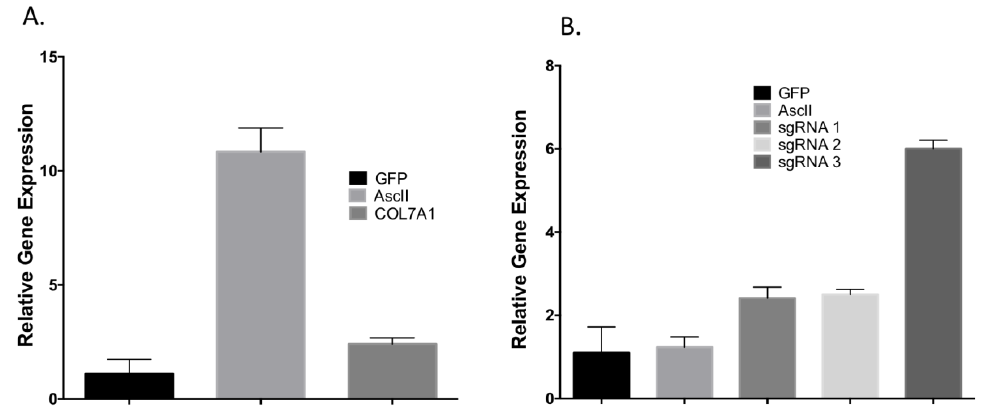
Figure A1. HEK 293T cells were lipofected with a catalytically inactive Cas9-VP64 plasmid and GFP (negative control) and candidate gRNAs. ( A ) Positive control. HEK 293T cells were transfected with GFP, a positive control gRNA (AsclI), and COL7A1 gRNA candidate three. At 72 h the cells were analyzed for AsclI gene expression. ( B ) COL7A1 candidate testing. The three COL7A1 gene candidate gRNAs, an AsclI gRNA, and a GFP transfection control were delivered to HEK 293T cells. COL7A1 gene expression was assessed at 72 h post gene transfer.